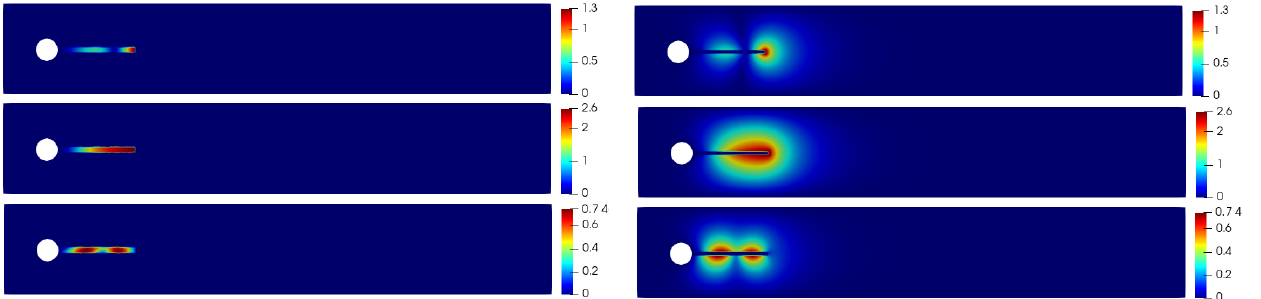
Figure 17. The first three POD modes for the solid displacement d s ( left column ) and the corresponding mesh displacement modes ( right column ) obtained with an harmonic extension of the basis functions on the left